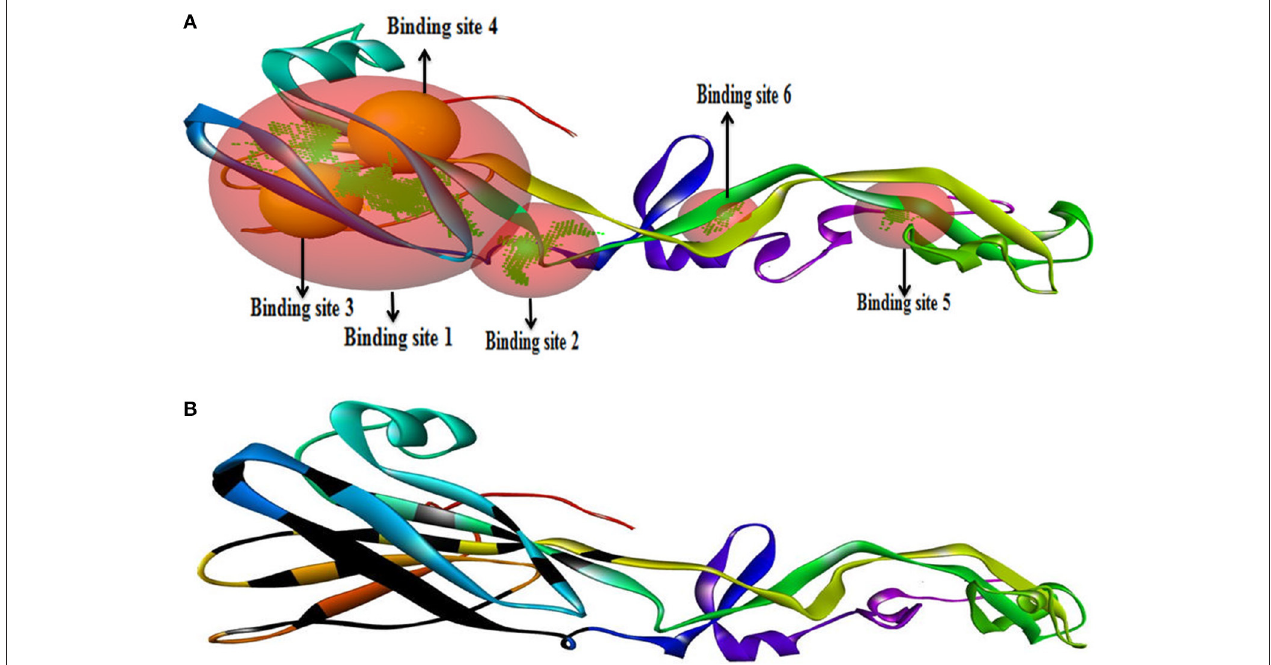
FIGURE 6 | Binding site of envelope glycoprotein (A) Active site amino acid residues of envelope glycoprotein. (B) The active site residues indicated with black color within envelope glycoprotein of WNV.